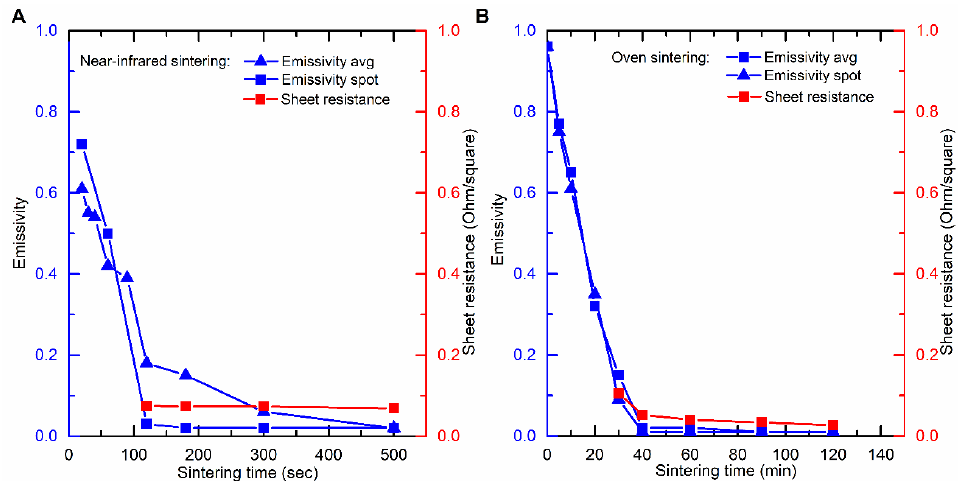
Figure 4. Average and spot emissivity during sintering correlate with the resulting sheet resistance of the ink layer for ( A ) NIR sintered JS-B40G ink and ( B ) oven sintered JS-B40G ink.